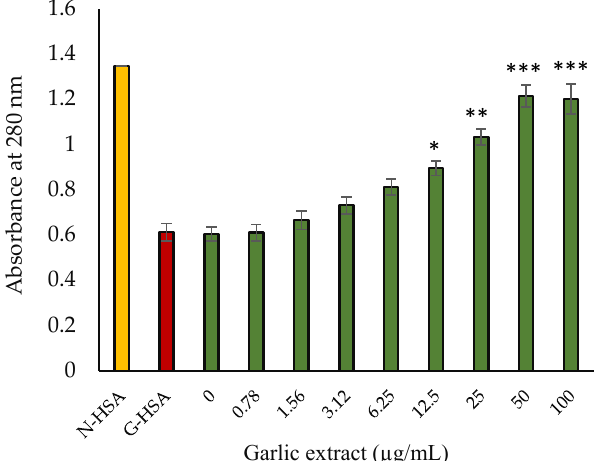
Figure 7. Absorbance of G-HSA vs. concentration of garlic extract. Native HSA and G-HSA were incubated for 10 weeks as negative and positive controls, respectively. G-HSA was incubated with various concentrations (0–100 µg/mL) of garlic extract (green). The results are presented as means ± SEM ( n = 3). Change in absorbance results (0.78–100 µg/mL garlic extract) were compared with G-HSA sample. Comparison between two groups was performed based on t test, and significance was defined as * p < 0.05, ** p < 0.01, *** p < 0.001. The formation of AGEs in the glycated samples was detected using AGE pentosidine- specific autofluorescence. For each sample, the specific fluorescence of AGEs was ob- served to be in the range of 400–480 nm. The fluorescence intensity vs. wavelength (400– 480 nm) spectra were found to be rather wide (data not shown), which might be attribut- able to the variety of fluorescent molecules created during the glycation process. Extract containing samples showed a steady reduction in AGE-specific fluorescence at 450 nm as the extract concentration increased in the incubated samples (Figure 8). The fluorescence intensity of HSA treated with glucose was maximum at 450 nm. Our data show that garlic extract exhibited protection against AGEs synthesis by glycation. Protection level in- creased as the concentration of garlic extract increased.